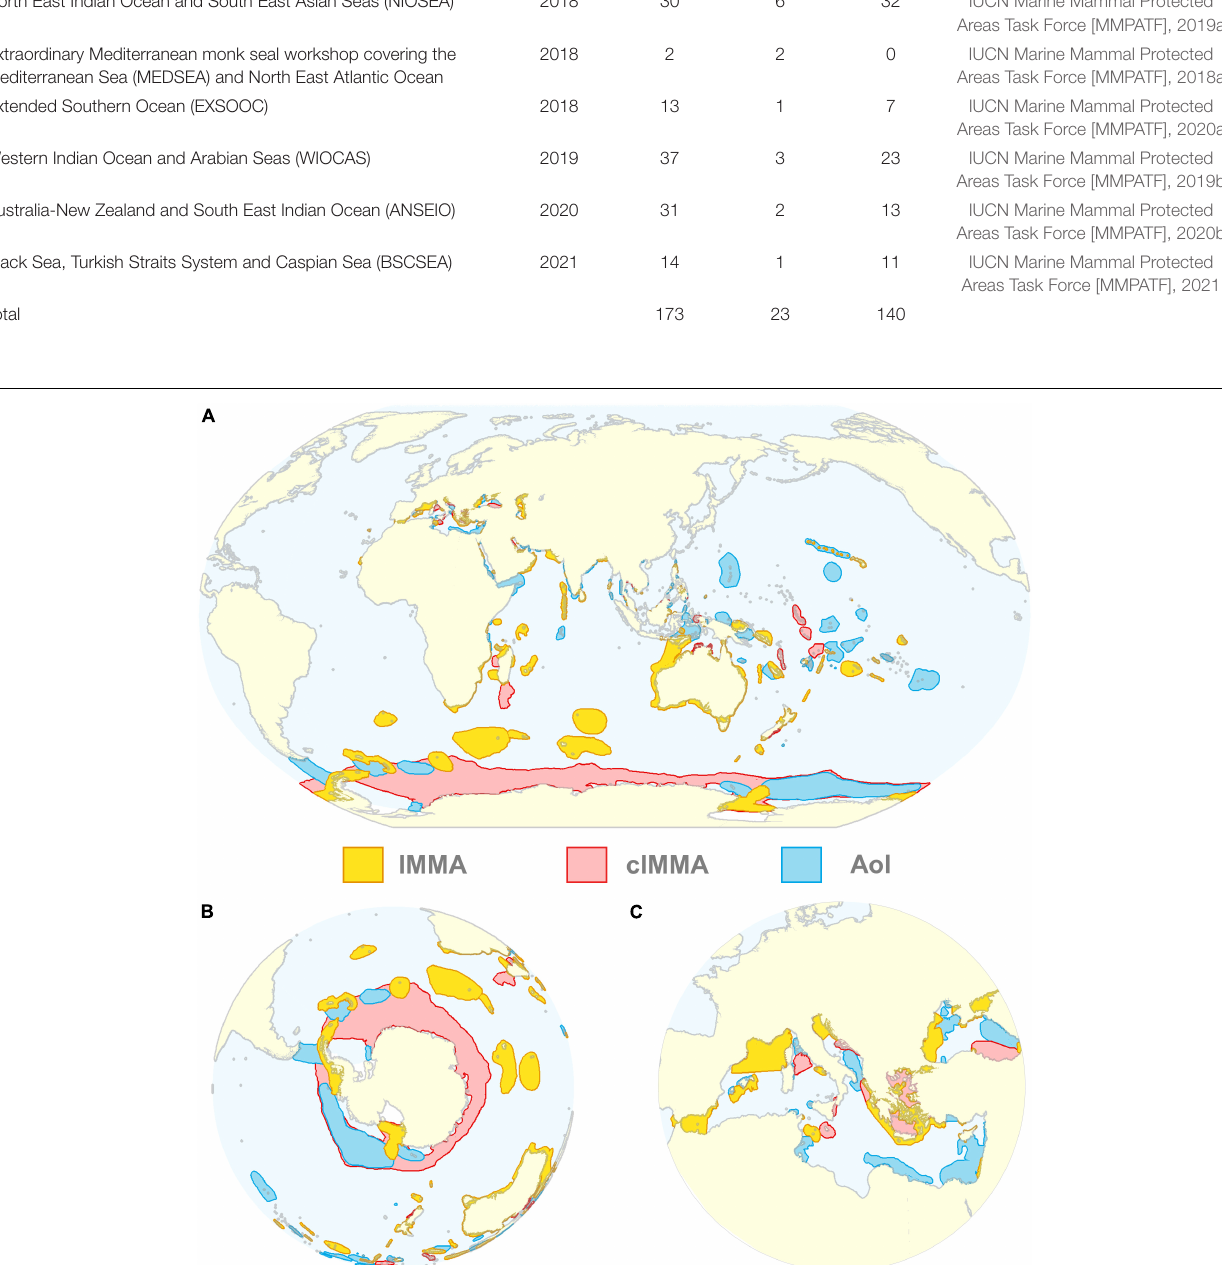
Frontiers in Marine Science |